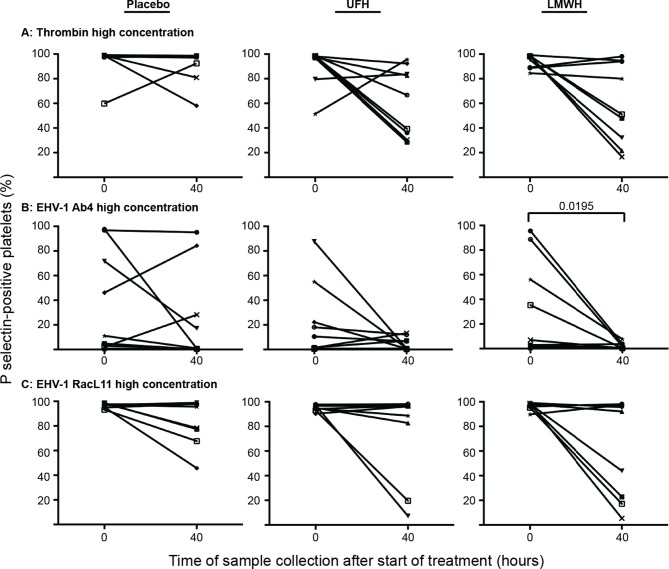
 Changes in the percentage of platelets expressing P selectin in platelet-rich plasma of 9 individual horses at 0 h (baseline) and 40 h after starting treatment (4 h after the last dose) with placebo (left column), unfractionated heparin (UFH, middle column) or low-molecular-weight heparin (LMWH, right column). Platelets were stimulated with high concentrations of thrombin (A), 0.5 U/ml) or the EHV-1 strains (5 × 106 PFU/ml), Ab4 (B) and RacL11 (C), for 10 min ex vivo. Significant changes in the median percentage of platelets expressing P selectin at 40 h compared to 0 h are shown. Each horse has the same unique symbol at both time points for all treatments (horse 1: -□-; horse 2: -○-; horse 3: -⋆-; horse 4: -⧫-; horse 5: -X-; horse 6: -▾-; horse 7: -·-; horse 8: -▪-; horse 9: -▴-).